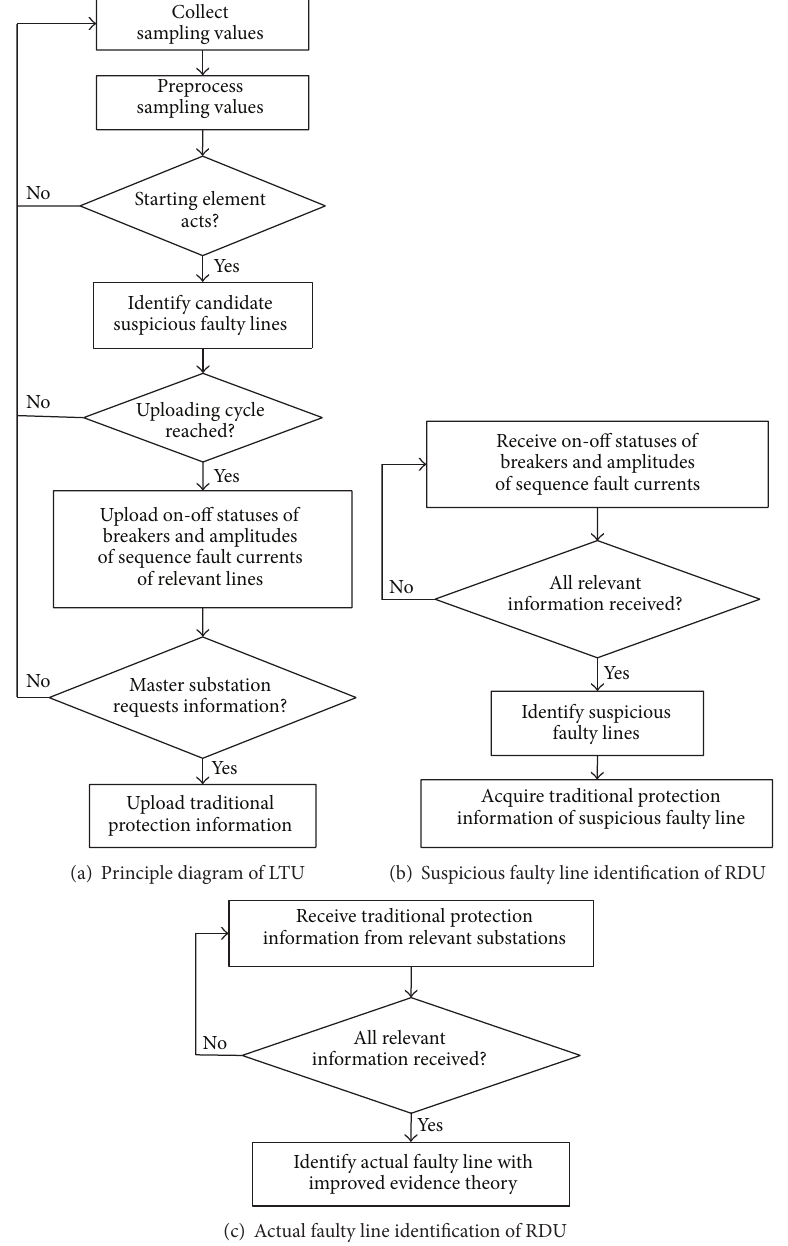
Figure 3: Fundamental principle diagram of the proposed